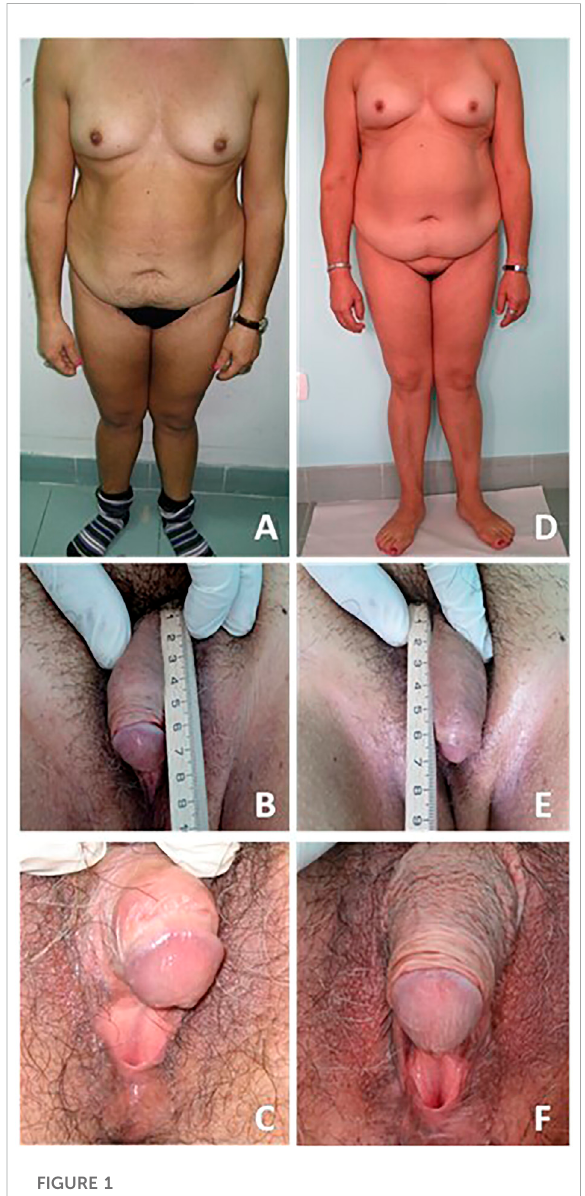
FIGURE 1 Patient bodily and genital characteristics. On the left side (A – C) are reported images related to the evaluation at diagnosis. On the right side (D – F) are reported images related to the last follow-up. A written informed consent was obtained by the patient in order to publish images and clinical